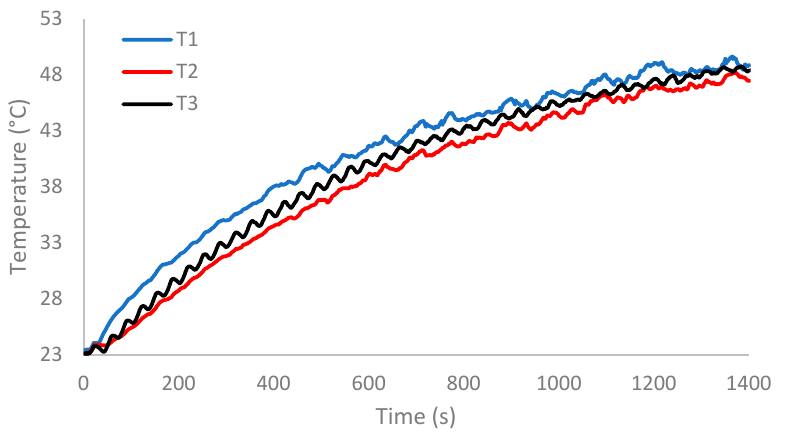
Figure 5. The temperature variation of the LiC cell employing HPCS as TMS at 23 °C initial tem- perature and 150 A charge/discharge current rate.